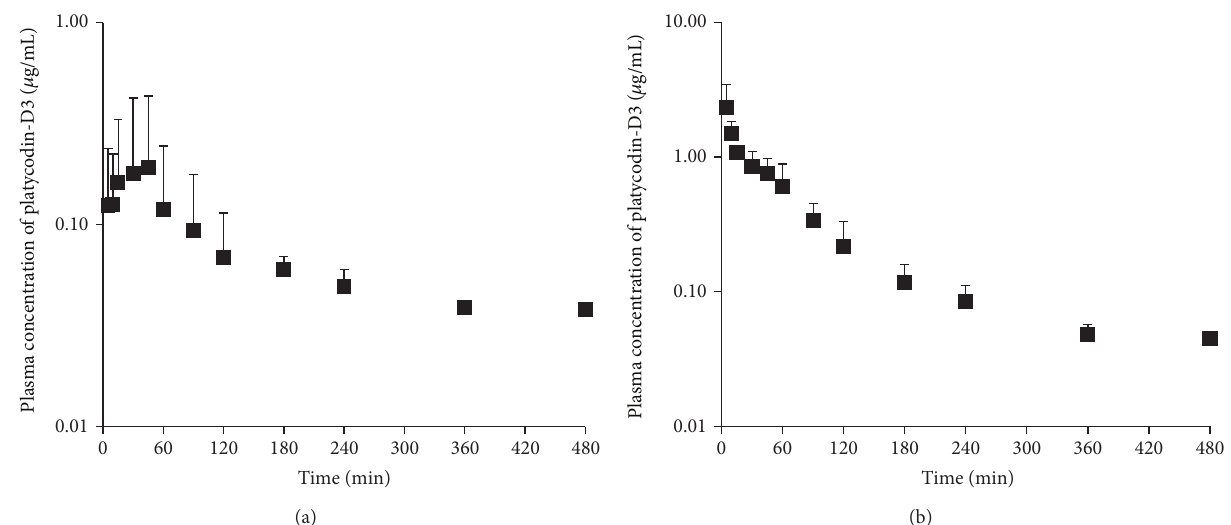
Figure 6: Mean plasma concentration-time profile of PD3 after intravenous administration of 25 mg/kg and oral administration of 500 mg/kg of PD-3% to rats ( 𝑛 = 4 ). Vertical bar represents standard deviation.